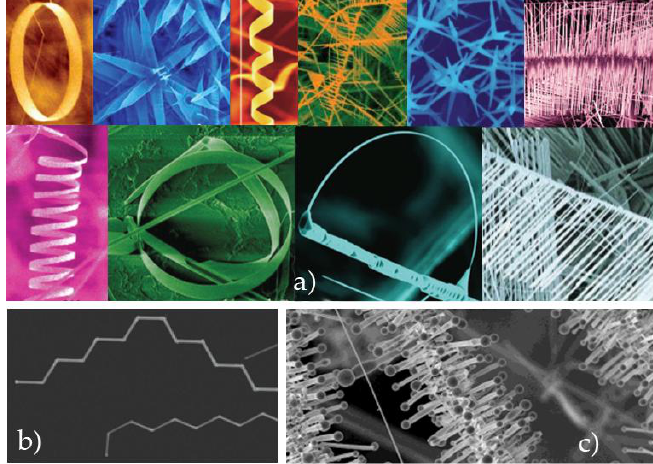
Figure 5. Existing nanowire morphologies, ( a ) spiral, spring, comb, ring, propellers, helix, saw, bows, tetrapoles, ( b ) zig-zig or kinked, ( c ) tinsel. (adapted from: ( a ) [61,67], ( b ) [68], ( c )